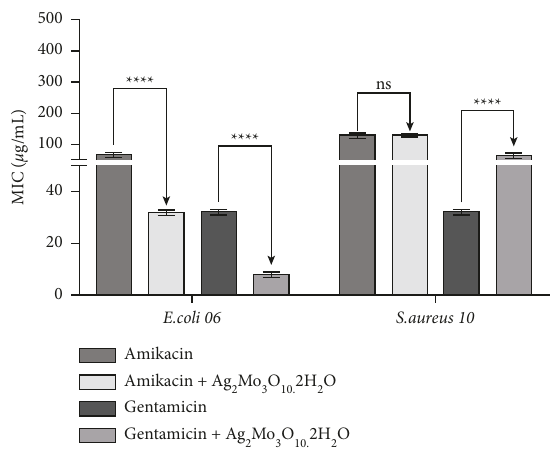
Figure 6: Minimum inhibitory concentration (MIC) of amikacin and gentamicin alone or in the presence of Ag 2 Mo 3 O 10 .2H 2 O, against multidrug-resistant strains of < i > S. aureus < /i > and < i > E. coli < /i > . ∗∗∗∗ P < 0 . 0001 indicates significant differences between groups. Statistical significance was determined by one-way ANOVA and Bonferroni’s post hoc